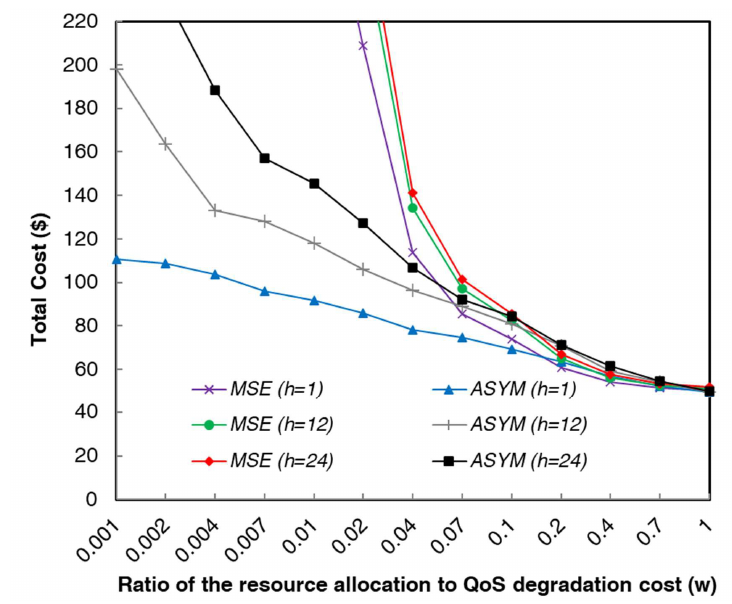
Figure 5. Cost in allocating resources for the NFV network of Figure 4 when w varies from 0.0001 to 1. The total cost is reported when the allocation algorithms use the MSE and ASYM LSTM predicted SFC bandwidth values and prediction steps h equal to 1, 12 and 24.